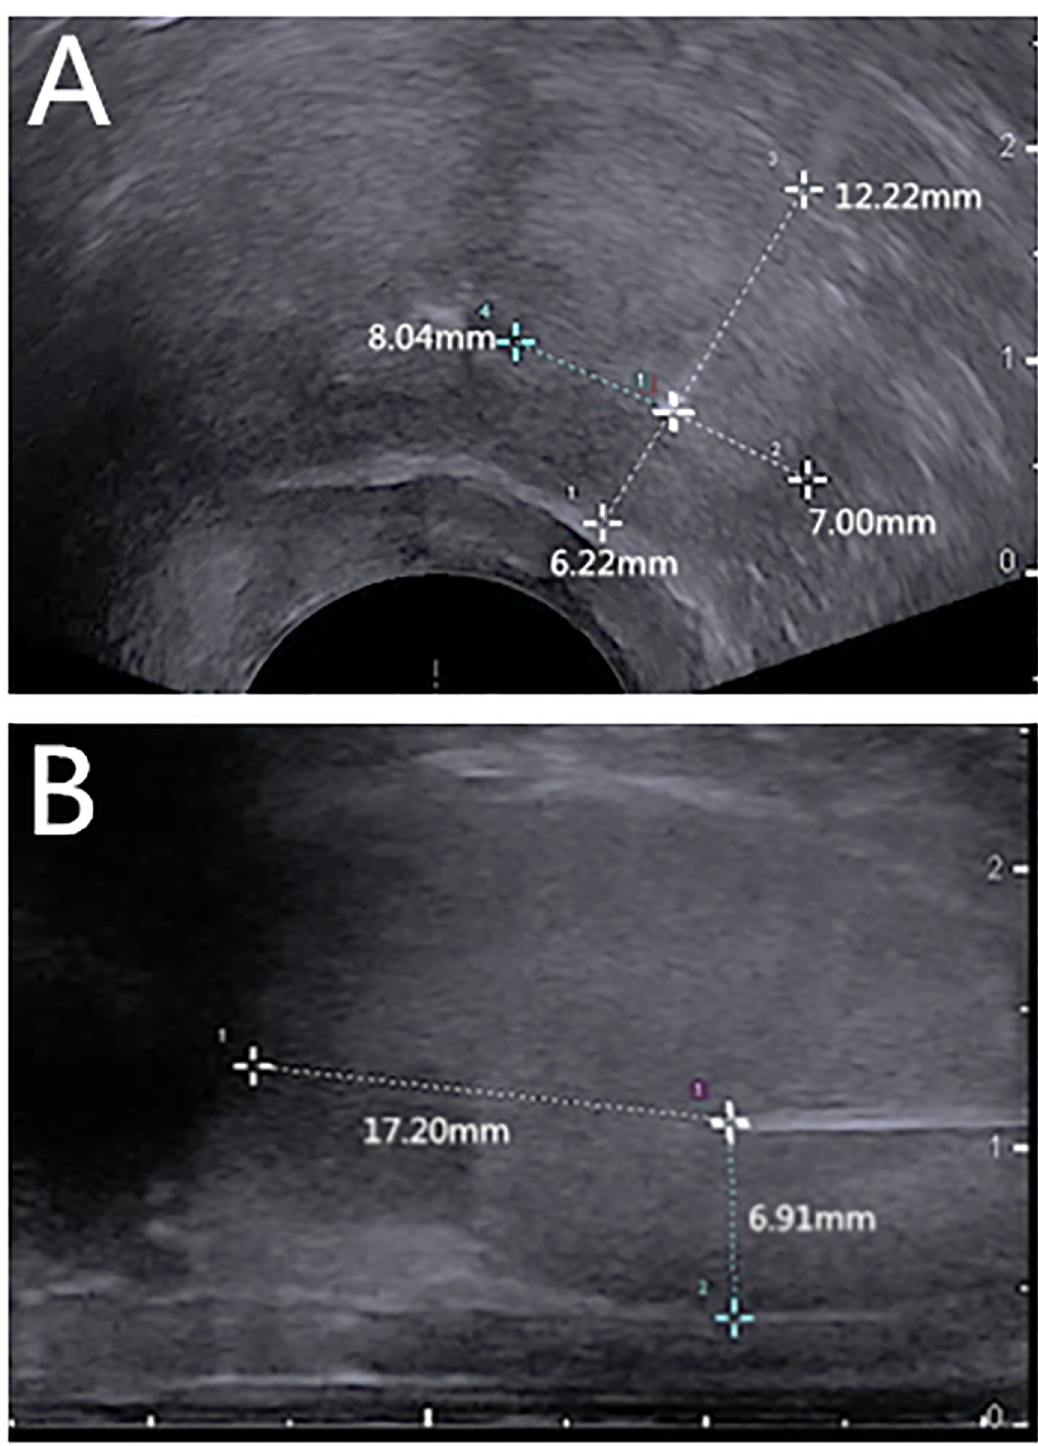
Fig 1. Distances from the tip of the laser fibre to the outer wall of the urethra, the rectum wall and the bladder floor on transrectal ultrasound images (A, transverse section; B, longitudinal section).